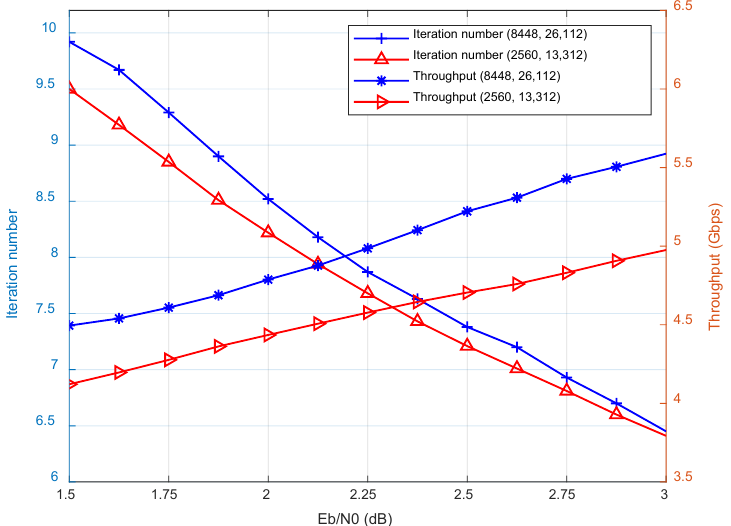
Figure 11. Effects of the early terminal mechanism on the number of iterations and throughput with the change in Eb/N0 (the codewords number is 256).